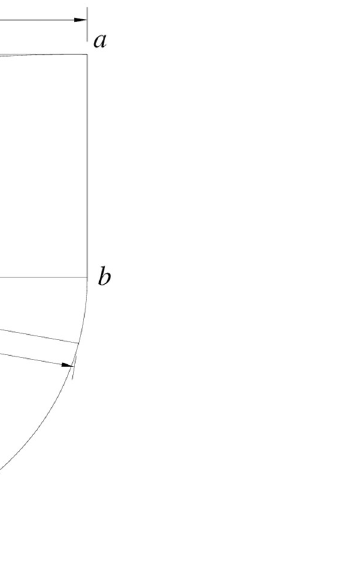
Fig 1. Deformation mechanism of foundation